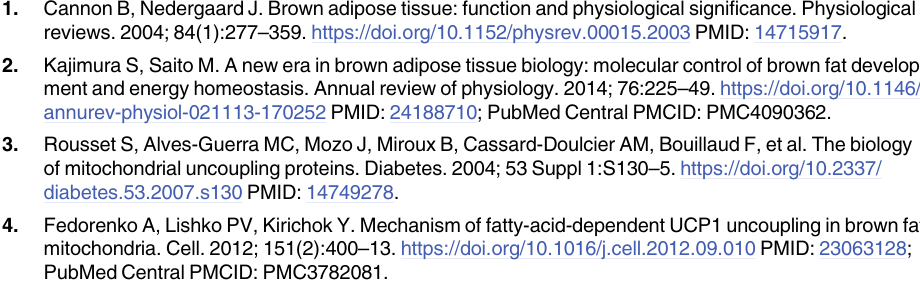
S1 Fig. Weight of different fat deports of HFD-fed mice. 20-week old male Ghsr f/f and UCP1 -Cre ER / Ghsr f/f mice fed HFD. The weights of epididymal fat, inguinal fat and BAT at ter- mination of the experiment. All data were expressed as the mean ± SEM. n = 3–6, � P < 0.05,